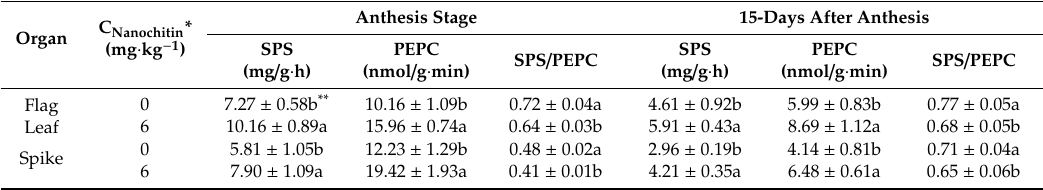
Table 5. E ff ects of nanochitin on enzymes activities for C and N metabolism at the anthesis and the 15 days after anthesis stages of winter